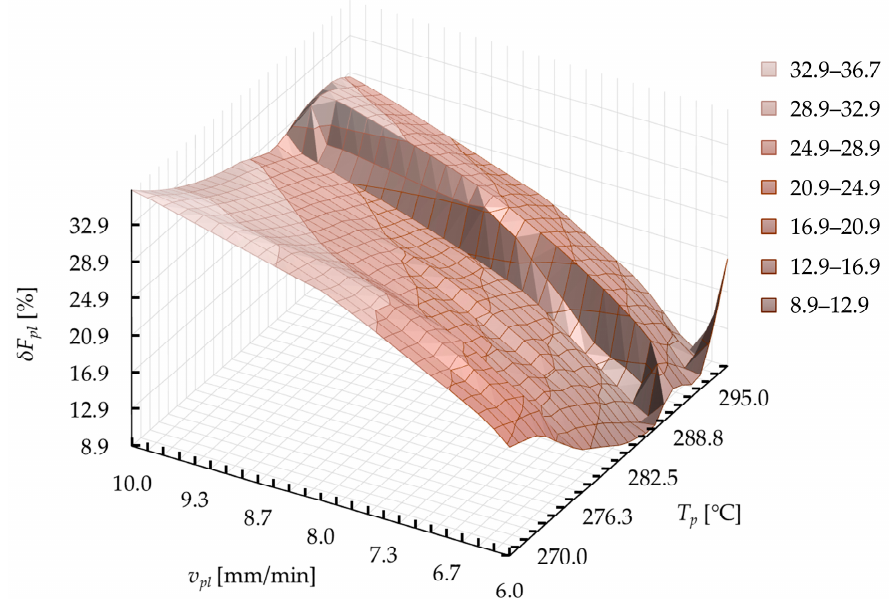
Figure 26. Exemplary results in the form of the surface of the function δ F pli in correlation with the hot plate temperature T p and the plasticization velocity v pl for the belt with diameter of 18 mm.